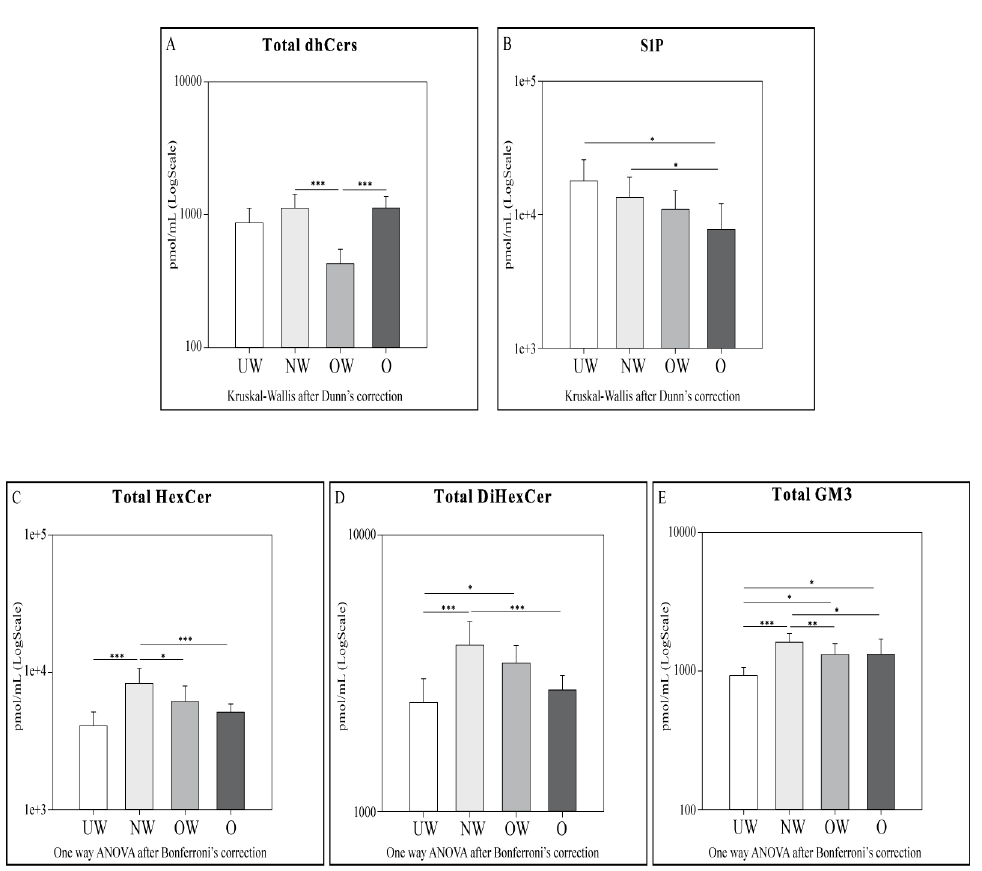
Figure 4. LC-MS and LC-MS/MS results for total dhCers ( A ), S1P ( B ), total HexCer ( C ), total dihexCer ( D ), and total GM3 ( E ). Data are expressed as pmol/mL in Log scale; p values are expressed as * ( D ), and total GM3 ( E ). Data are expressed as pmol / mL in Log scale; p values are expressed as * p -value < 0.05, ** p -value < 0.01, and *** p -value < p -value < 0.05, ** p -value < 0.01, and *** p -value < 0.001.